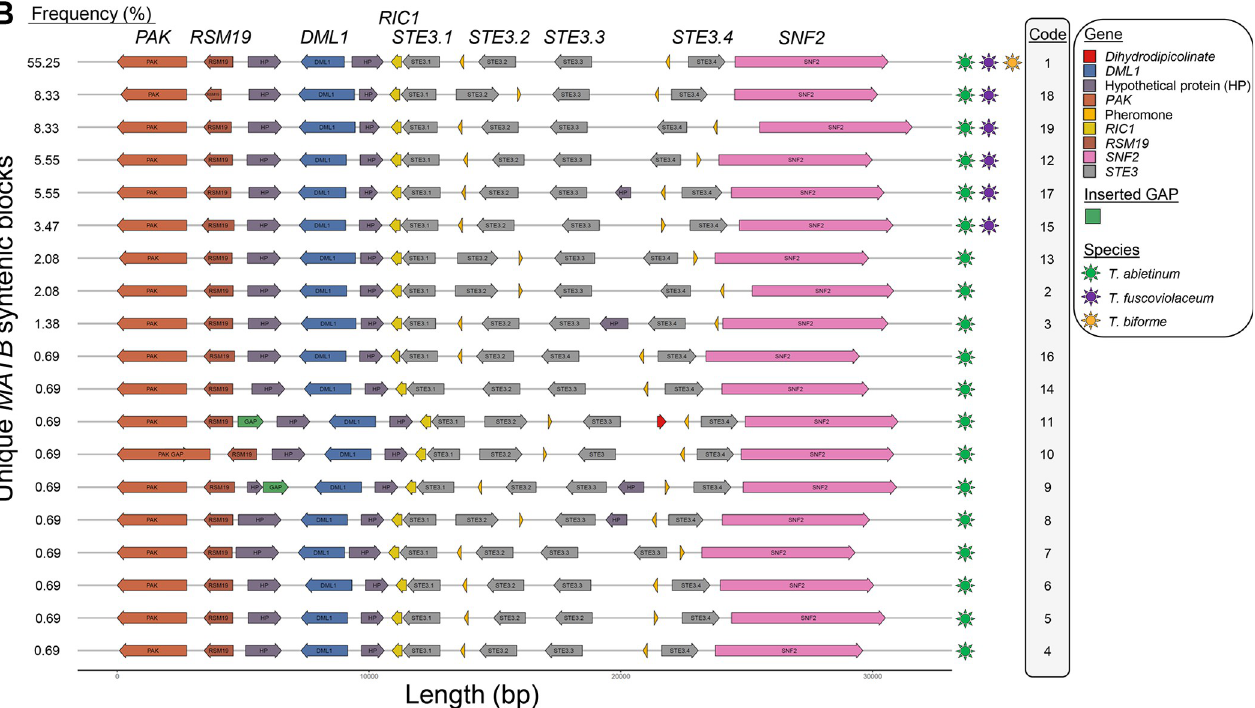
Fig 6. Mating B region is highly dynamic and show multiple rearrangements among Trichaptum strains. MATB gene order representations for Trichaptum strains with MATB genes assembled in one contig. We showed the MATB region for those strains where the assembly was contiguous from RIC1 to SNF2 . In some strains, the region from RIC1 to PAK was contained in multiple contigs. Those contigs were joined (ultrascaffolding) and ordered according to the reference genomes (see Material and Methods section). To ultrascaffold, we inserted 999 Ns between joined contigs, annotated as a GAP in the legend. For that reason, GAP label is drawn. The percentage of strains containing a specific MAT block order is indicated in the left. Genes were colored according to the legend on the right. Species containing a particular MAT block are represented by colored stars at the right of the MAT block and were colored according to the legend. Coding sequence direction is represented by the arrows. Code numbers link the strains in S2 Table with the displayed mating structure.